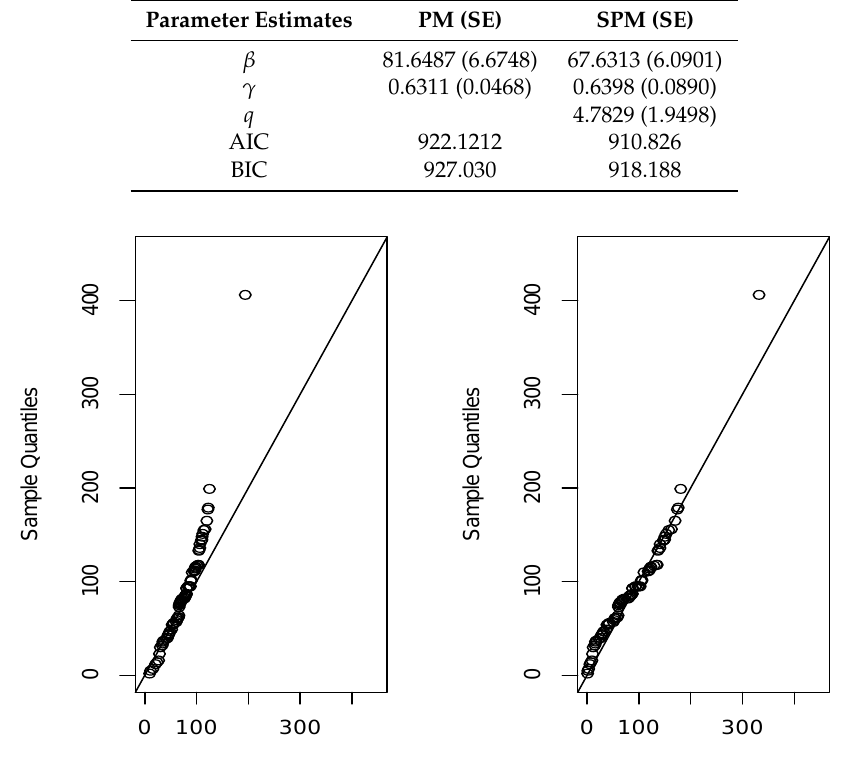
Parameter estimates, standard error (SE), and values for PM and SPM models for Rubidium concentration.